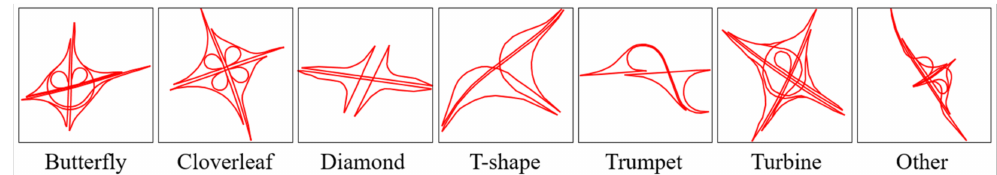
Figure 7. Examples for the seven types of complex road junctions.